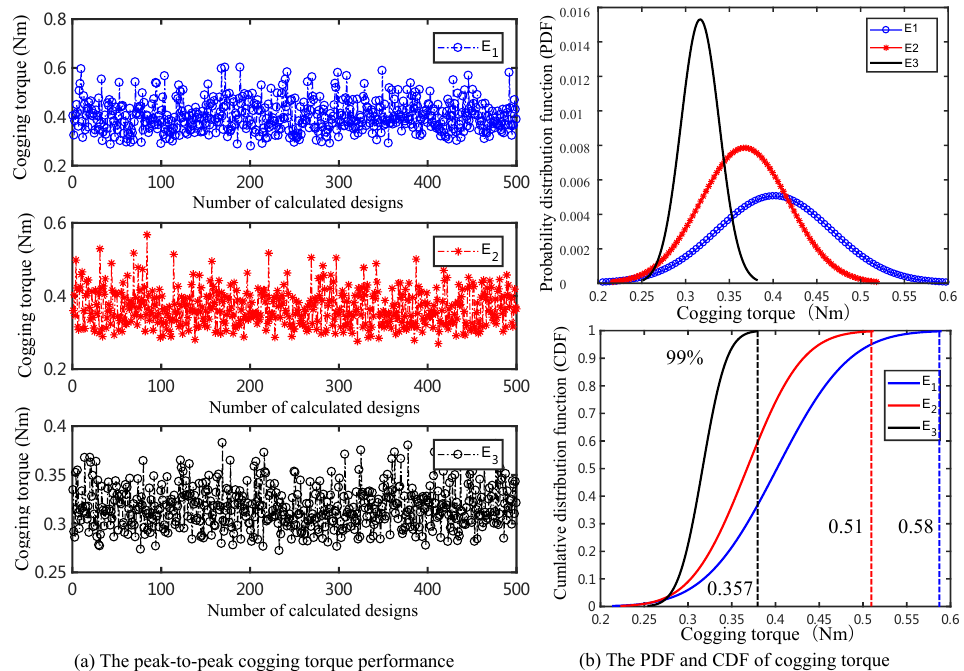
Figure 14. The peak-to-peak cogging torque performance with different PM assembling approaches ( E 1 to E 3